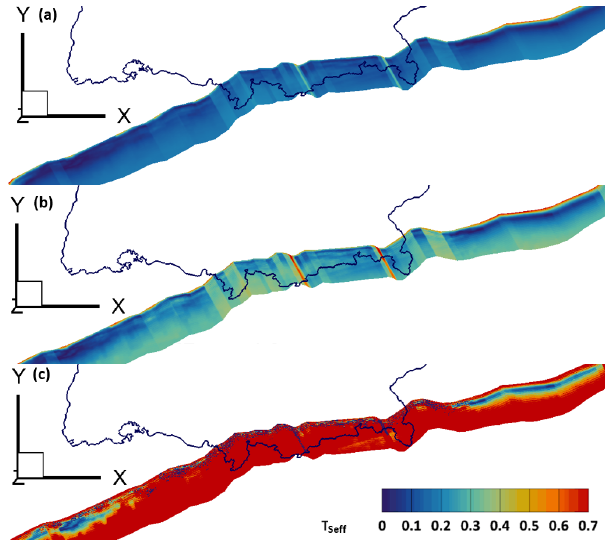
Figure 11. T Seff of the Alpine Thrust for different pore pressures. (a) T Seff with hydrostatic pore pressure corresponding to a gradient of 10MPakm − 1 ; (b) T Seff for an overpressured pore pressure with a gradient of 16MPakm − 1 ; (c) T Seff for an overpressured pore pres- sure with a gradient of 22MPakm − 1 . The color bar applies to all three cases. ©EuroGeographics for the administrative